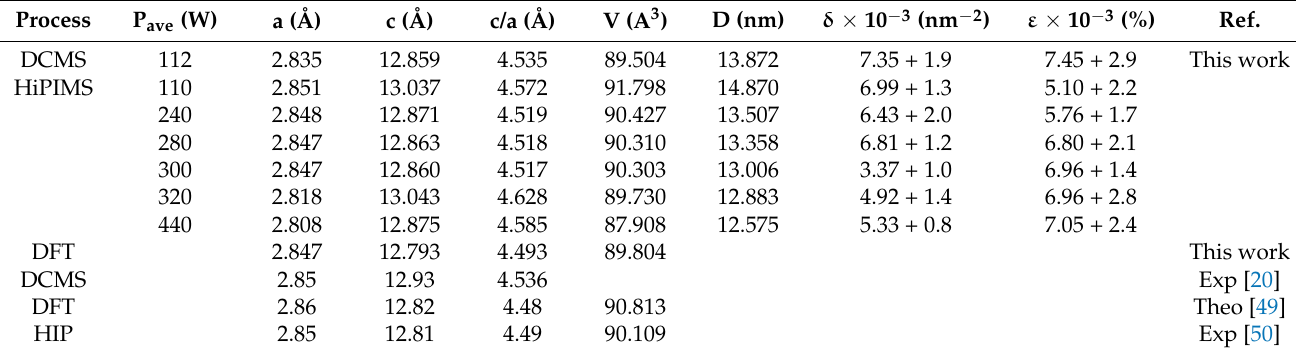
Table 2. Lattice parameters (a, c), crystal size (D), dislocation density ( δ ), and micro strains ( ε ) were calculated from the X-ray diffraction (XRD) data of the coatings prepared by DCMS and HiPIMS in comparison with the lattice parameter calculated by DFT-generalized gradient approximation (GGA) of bulk Cr 2 AlC MAX